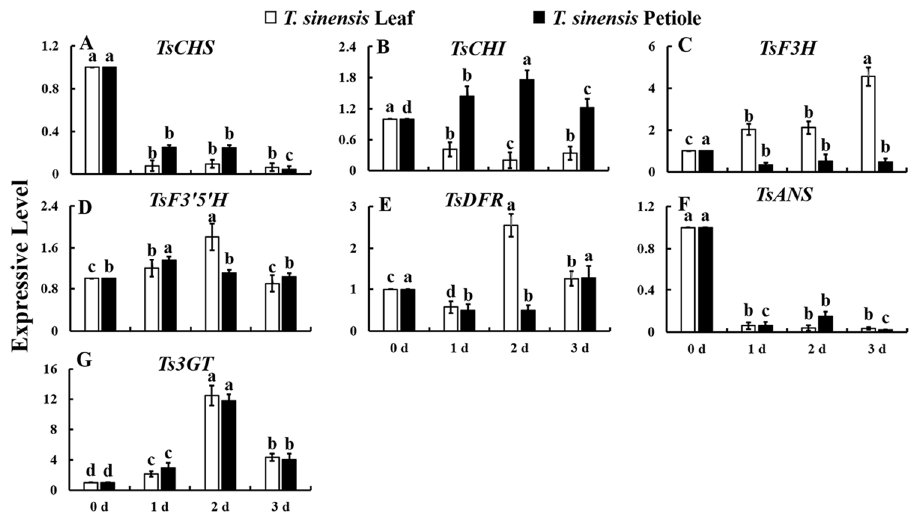
Figure 5. Relative expression level of anthocyanins-related genes of red T. sinensis buds during storage. ( A ): The expression level of TsCHS in red T. sinensis during storage; ( B ): The expression level of TsCHI in red T. sinensis during storage; ( C ): The expression level of TsF3H in red T. sinensis during storage; ( D ): The expression level of TsF3’5’H in red T. sinensis during storage; ( E ): The expression level of TsDFR in red T. sinensis during storage; ( F ): The expression level of TsANS in red T. sinensis during storage; ( G ): The expression level of Ts3GT in red T. sinensis during storage. Different lowercase letters on the column indicates significant differences among different treatments ( p < 0.05).